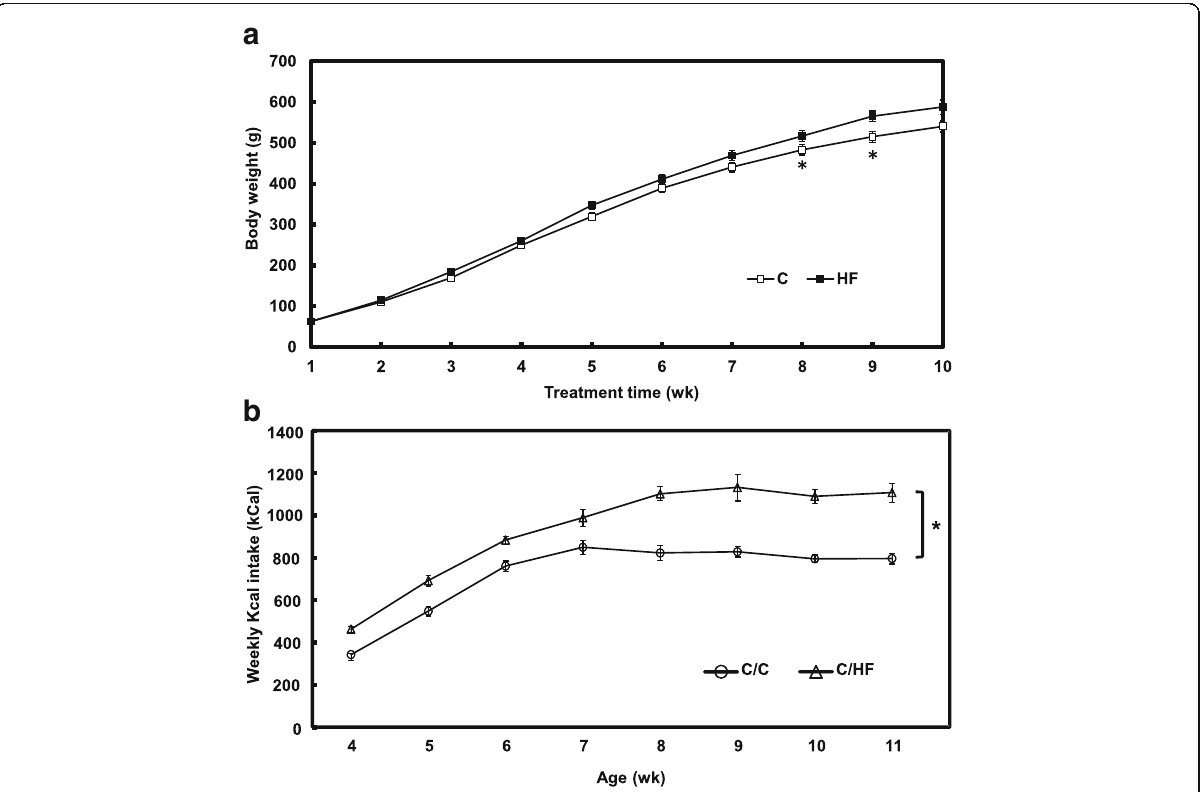
Fig. 1 Physiological outcome of rats fed high-fat diet and control diet. a Effect of different diets on body weight of C and HF rats through 9 weeks of feeding. Values are mean ± SEM, p < 0.05*. b Energy intake graph of rats fed with different diets: control (C, n = 10) diet, and high-fat (HF, n = 10) diet. Values are mean ± SEM. p <